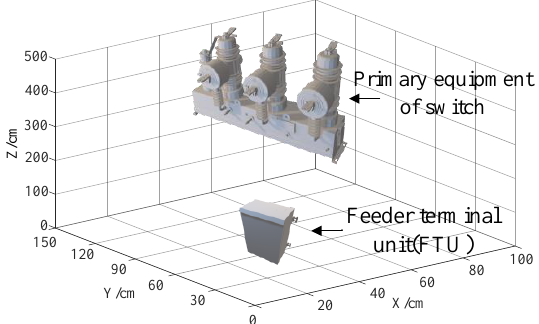
Figure 15. Simulation model of distribution switch with FTU.